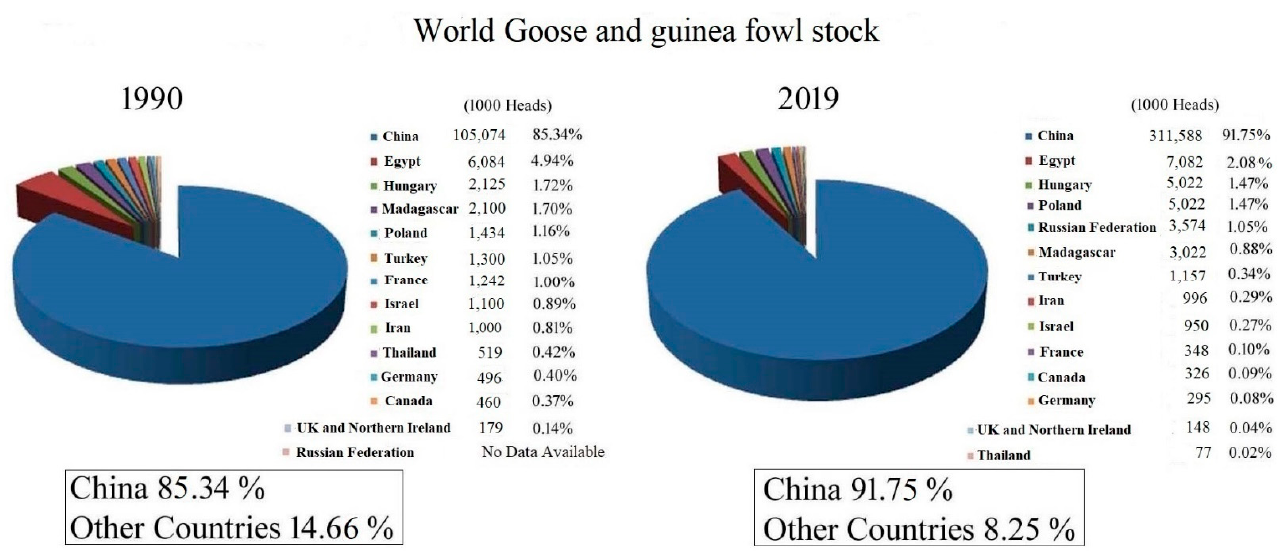
Figure 1. World goose and guinea fowl population in 1990 and 2019 according to FAOSTAT [2]. Geese are a popular source of eggs, meat, fat liver, goose fat, down, and feathers in numerous parts of the world [6–10]. Foie gras is a special food product obtained from duck and goose liver by gavage (force feeding) and is especially popular in French cuisine and countries such as Hungary, Poland, Israel, the USA, and Canada [9,10]. For more than 2000 years, goose feathers have been used for duvets and pillows [10]. Goose feathers and